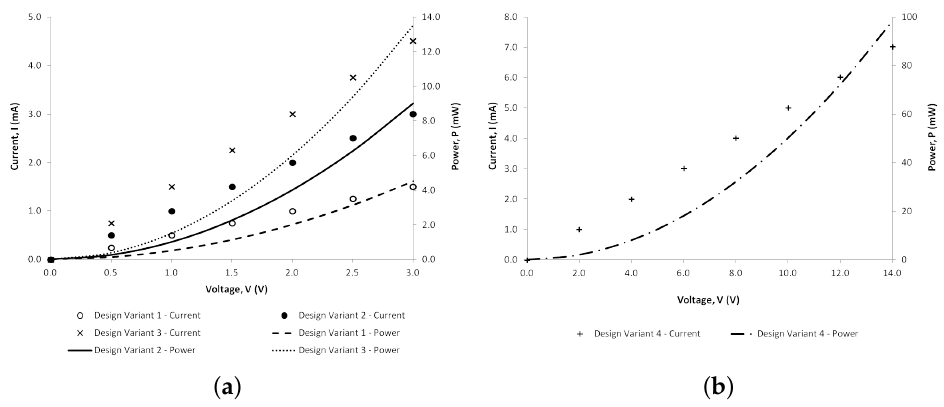
Figure 14. Numerical variation of the current and power dissipated with voltage across each arm of the microgripper structure for Design Variants 1-3 ( a ), and for Design Variant 4 ( b